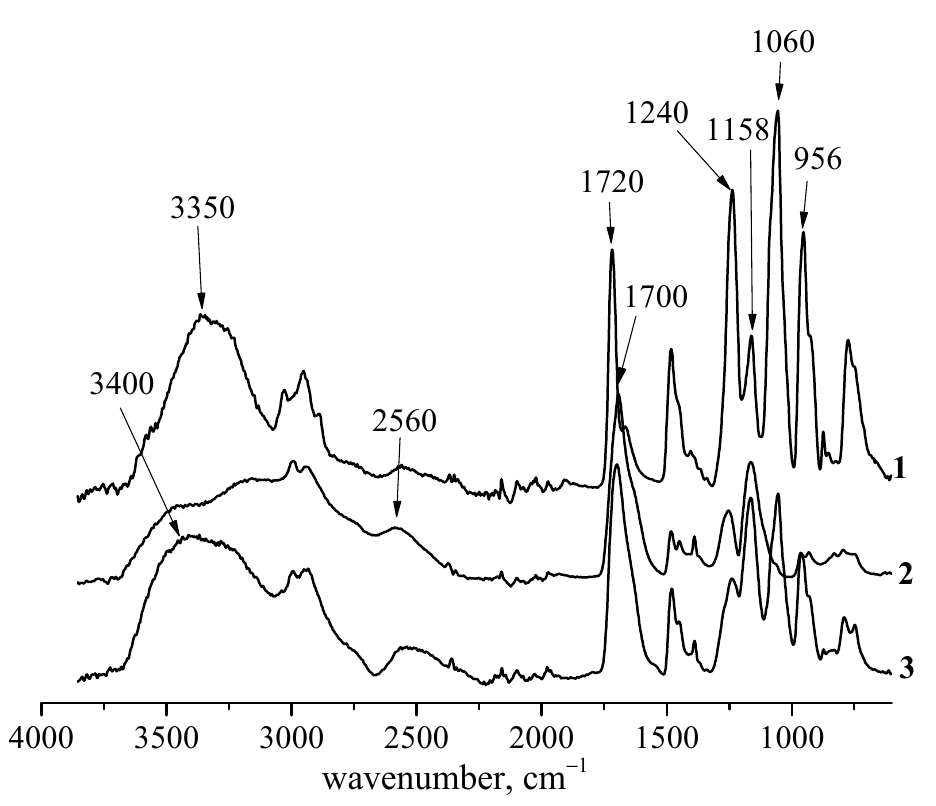
Figure 4. IR-ATR spectra of PMPC (1), PMAA (2), and their associate (3). An intense band at 1240 с m − 1 in the PMPC spectrum is attributed to vibrations of P=O groups. The shift of the P=O vibration band in the PMPC spectrum from the position typ- ical of the P=O groups of alkylphosphoric acid esters (1290–1260 cm –1 in the spectra of organophosphorus compounds) is caused by the inductive influence of substituents on the type of P=O bond and formation of a zwitterion with a high dipole moment (~15 D). The band in the 1170–1150 с m − 1 region is assigned to vibrations of the Р – О –C 2 H 4 -group. The vibration band of the Р – О – С -group is also observed in the 1060–990 с m -1 area [28]. The frequencies of stretching vibrations of polymer groups and their changes upon the formation of complexes are shown in Table 2. Table 2. Stretching vibrations of polymer groups and their changes upon the formation of com- plexes.